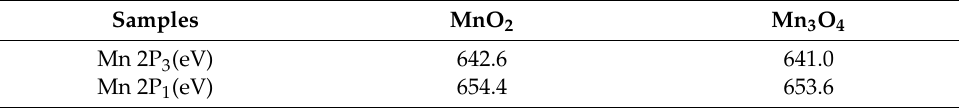
Table 2. The binding energy of Mn 2P of MnO 2 and Mn 3 O 4 .